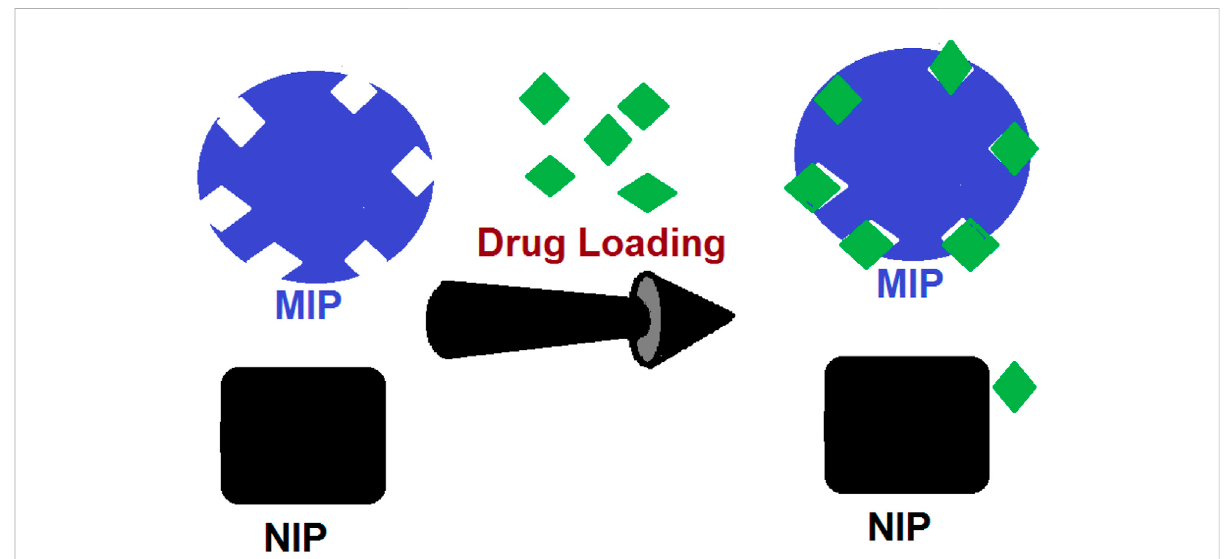
FIGURE 1 Process of absorption of the drugs by MIP substrates compared to the adsorption by